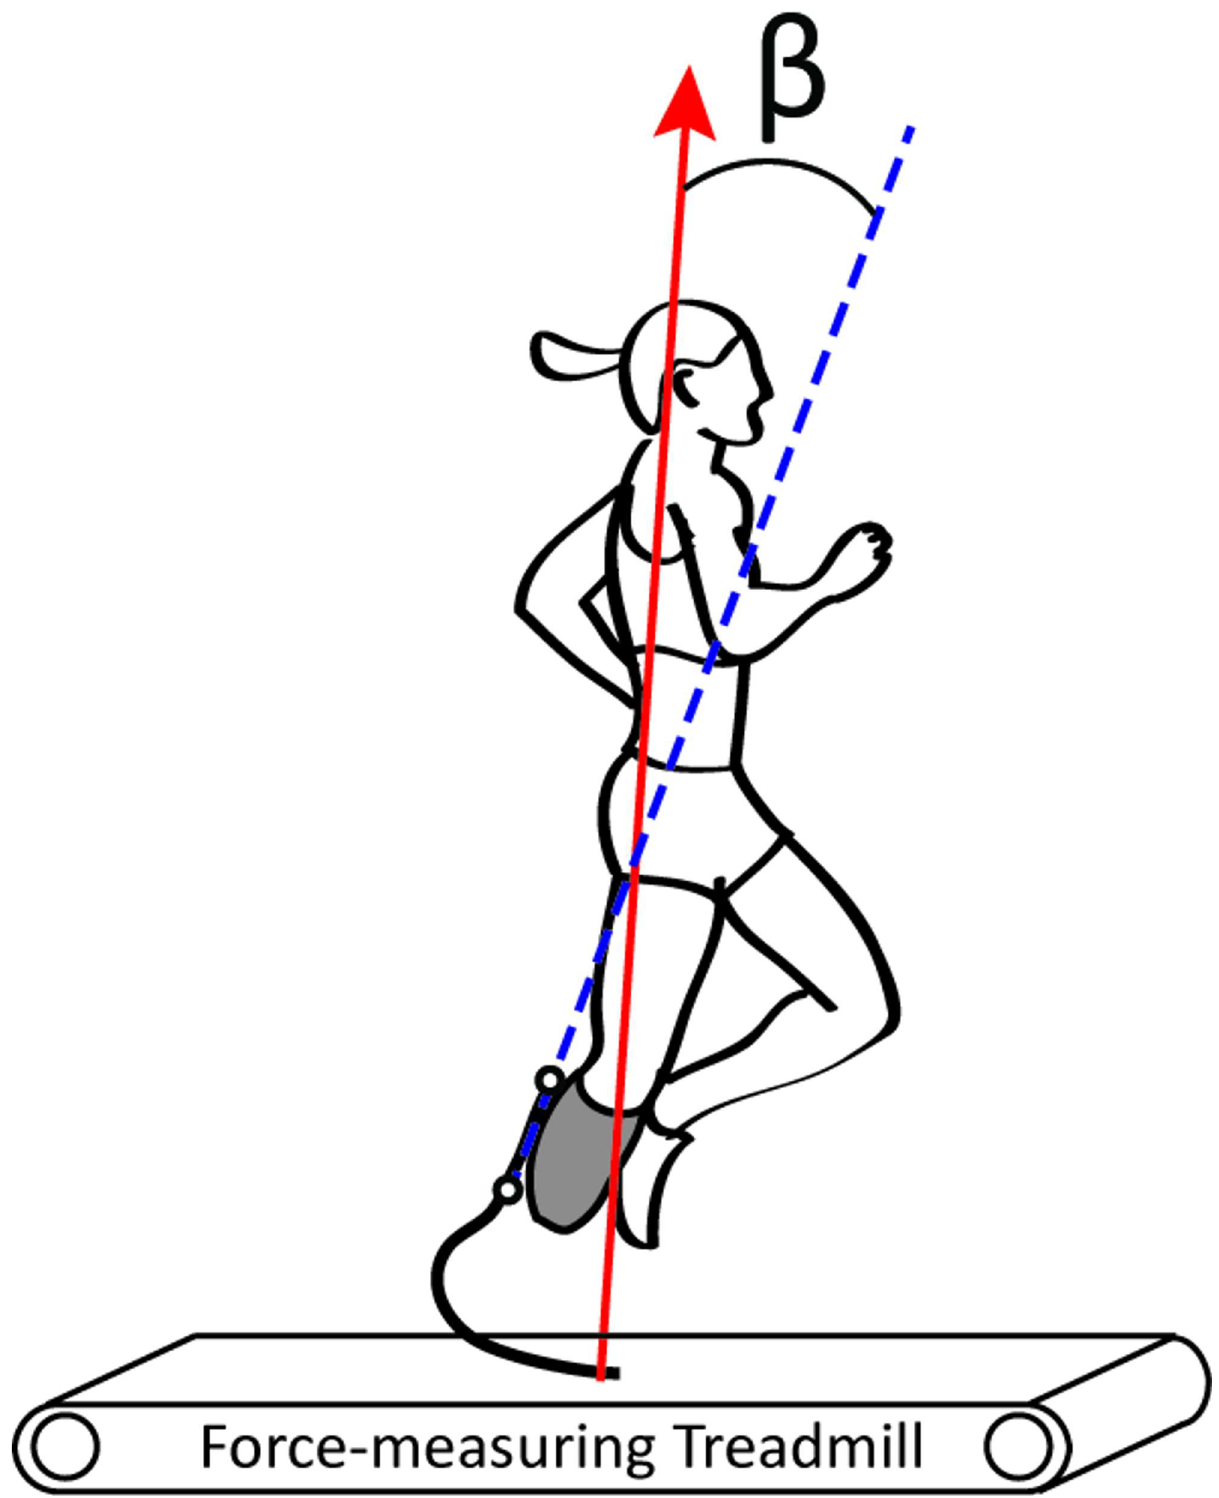
Fig 1. Biomechanics of running. Illustration of the calculatedangle( β ) betweenthe longitudinal axis of the running-specific prosthesis (dashedblue line) and the peak resultant GRF vector (solidred arrow).